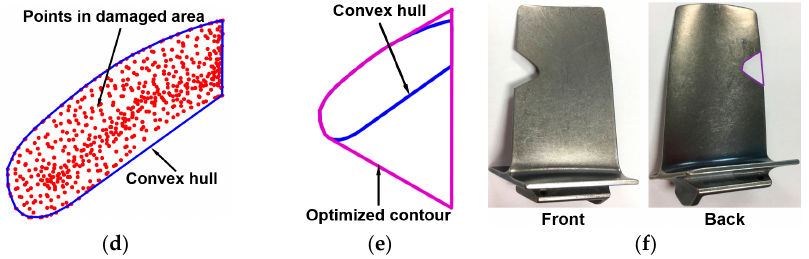
Figure 12. ( a ) Damaged blade; ( b ) 3D model of the blade; ( c ) point cloud in damaged area; ( d ) convex hull of the point cloud; ( e ) optimized contour for machining; ( f ) blade after machining.